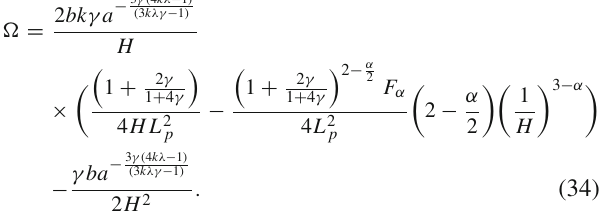
Figure 7 represents that the trajectories of (cid:10) against a with respect to three values of γ approach to zero which indicates the validity of first law of